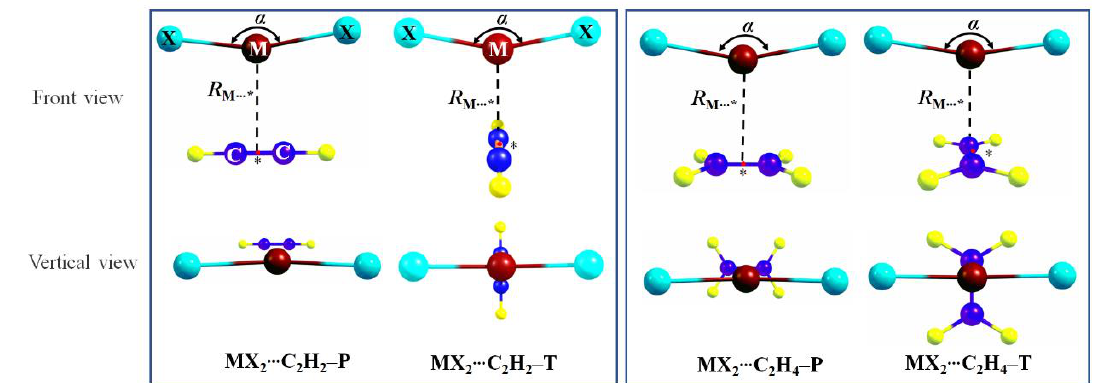
Figure 2. Schemes of spodium –π bonded binary complexes. Dark red is the M atom (M = Zn, Cd, Hg), cyan is halogen atom X (X = Cl, Br, I), blue is C atom and yellow is H atom. Binding distance R M··· * between the M in MX 2 and the centers of C –C bond in π molecules ( * denotes the center of C –